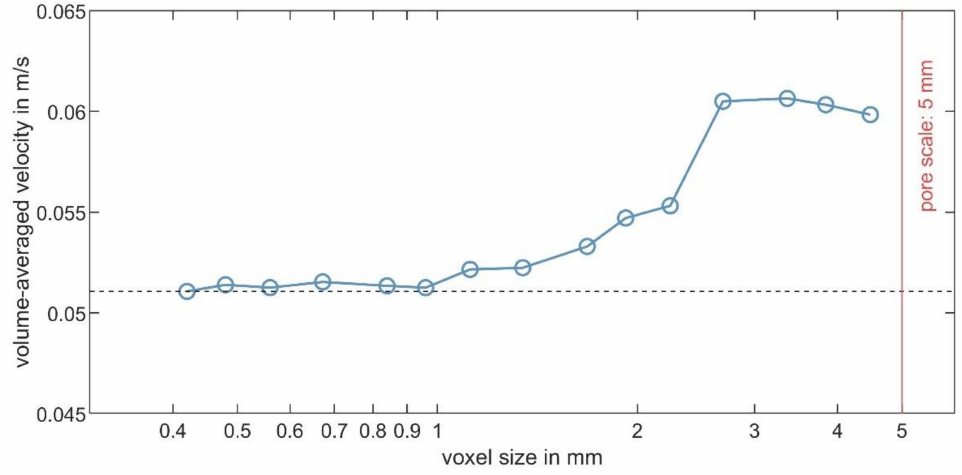
Figure 9. Volume-averaged velocity in the fluid-filled space as a function of the voxel